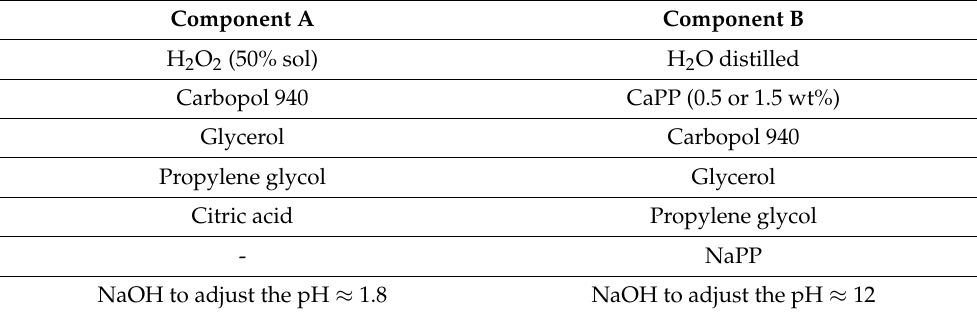
Table 3. Composition of the experimental bleaching gels (components A and